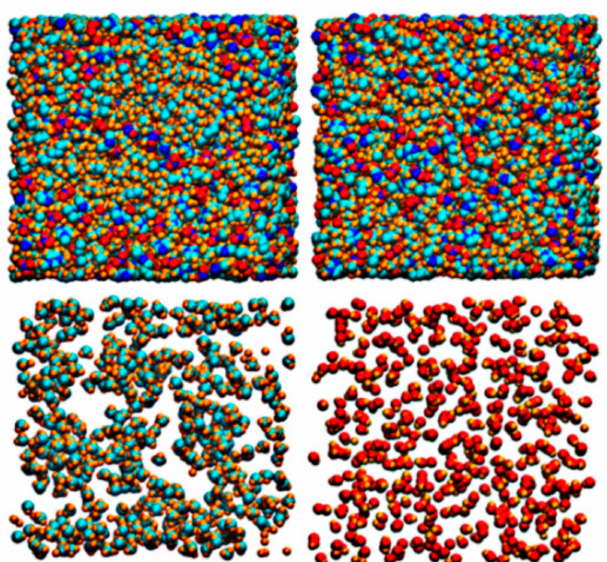
Figure 4. Random snapshots of C 8 (left column) and C OH (right column). First row: all atoms; second row: terminal groups (CH 3 for C 8 and OH for C OH ) only. Carbon atoms are colored with cyan, nitrogen with blue, oxygen with red, and hydrogen with gold [47]. Reprinted with permission of